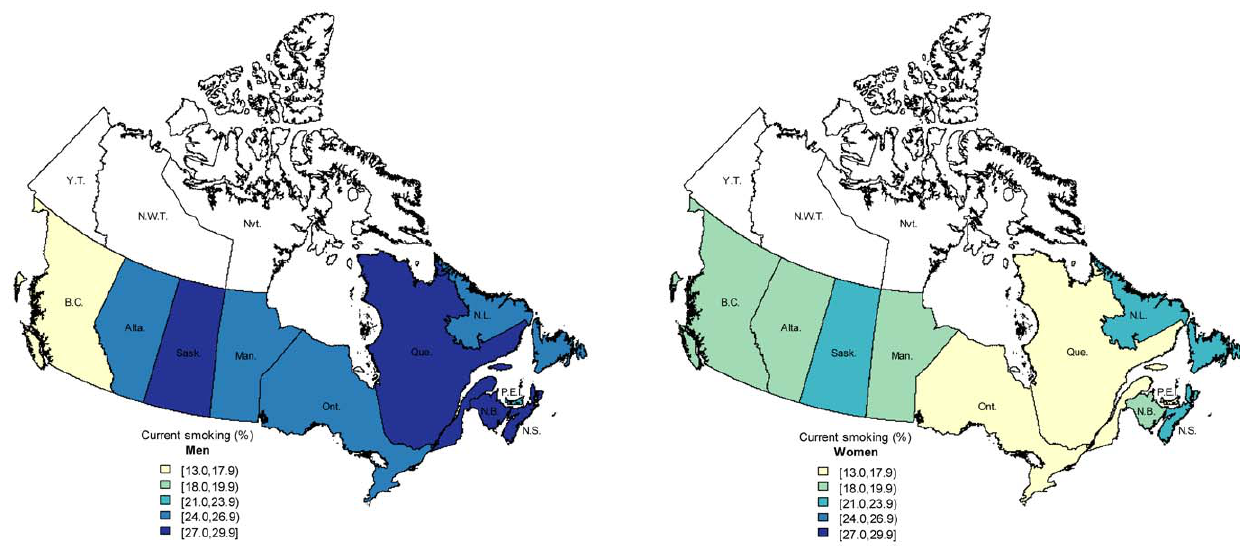
Figure 1. Adjusted prevalence of current smoking in Canadian provinces for men (left) and women (right) aged 15 years and above, Canadian Tobacco Use Monitoring Survey 2010. Darker colours indicate higher prevalence. Estimates adjusted for age, sex, marital status, occupation, education. Province name abbreviations: Alta. Alberta; B.C. British Columbia; Man. Manitoba; N.B. New Brunswick; N.L. Newfoundland; N.S. Nova Scotia; O.N. Ontario; P.E.I. Prince Edward Island; Que. Quebec; Sask. Saskatchewan; data not available for Yukon Territory (Y.T.), Northwest Territories (N.W.T), or Nunavut (Nvt.).